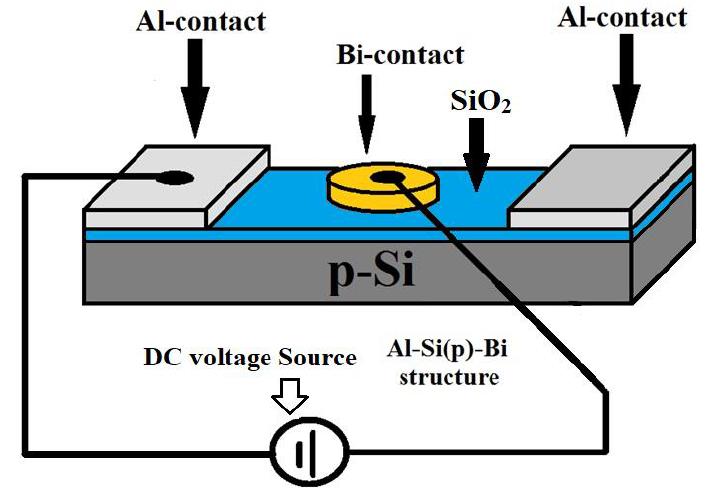
Figure 1. Bi-Si-Al surface barrier structure.